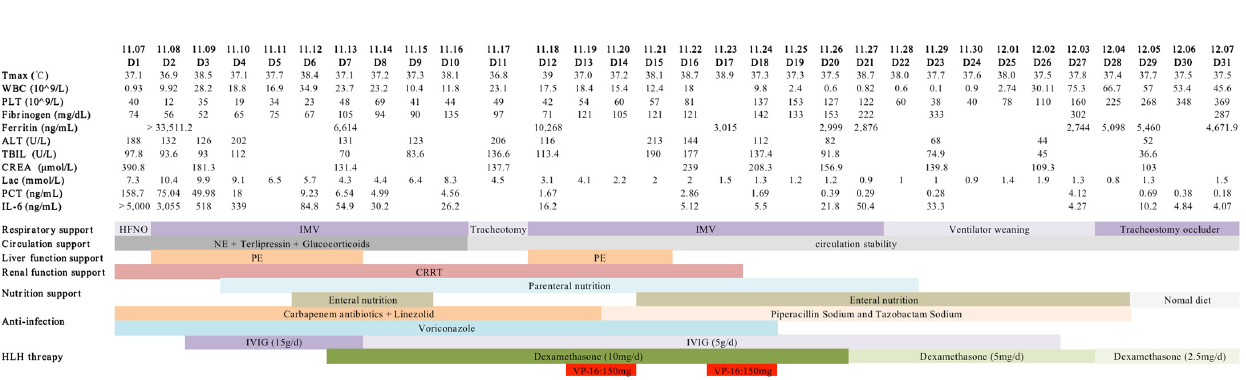
Figure 4. Timeline of the course of disease treatment based on the number of days in the ICU. From 7 November to 7 December 2021. Abbreviation: IMV, invasive mechanical ventilation; NE, norepinephrine; PE, plasma exchange; CRRT, renal replacement therapy; IVIG, intravenous immunoglobulin.